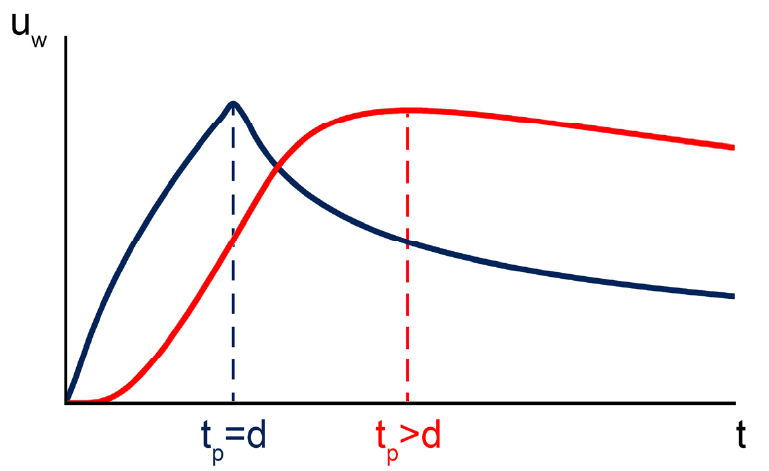
Figure 2. Relationship between t p and d , for different values of a . As can be seen, t approaches d for small values of a , i.e., at shallow depths and/or p c (or highly permeable soils). By contrast, for high values of t could be significantly w p u with time assumes a different that d at high depths and for poorly permeable soils. Consequently, depending on depth w and hydraulic conductivity, the evolution of u w with time assumes a different shape, as shown in Figure 3. In this figure, the blue curve corresponds to a case with t p = d , and the red curve is representative of a case when t p > d . A slope failure could occur before the end of the rainfall in the first case, whereas failure likely occurs after the rainfall event in the second case.